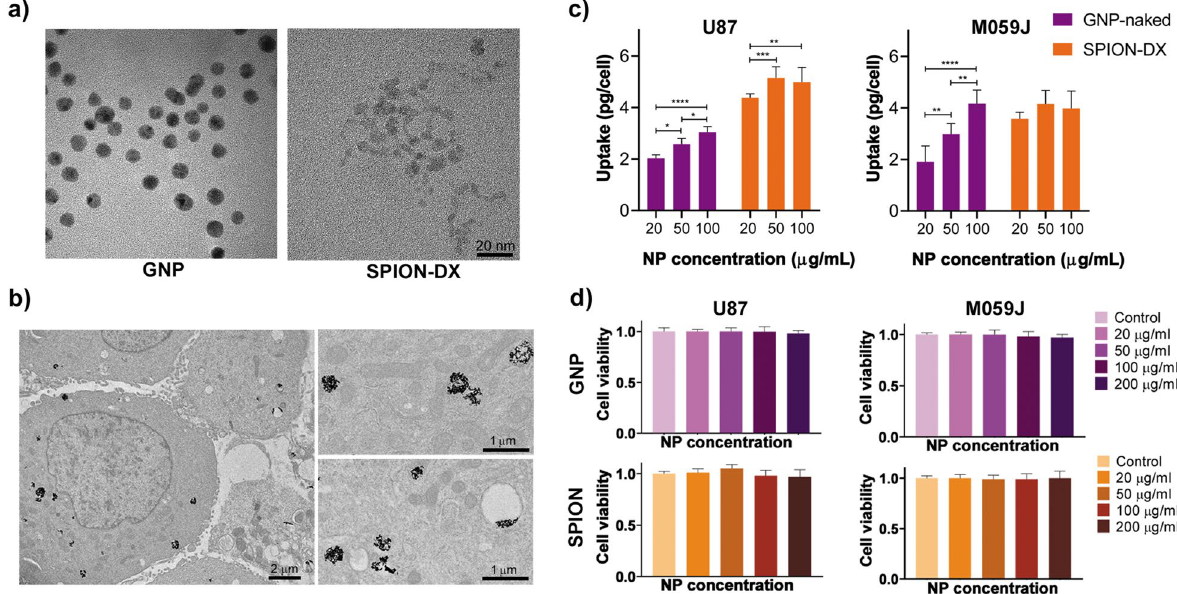
Figure 1. Nanoparticle characteristics and interaction with cells. ( a ) TEM images of GNPs (left) and SPION-DX (right). The scale bar applies to both images. ( b ) TEM micrographs of U87 cells exposed to 50 µ / mL GNPs showing NPs (black spots) localized within the cytoplasm. On the right, magnified TEM images from the same cell, showing the NP aggregates within vesicles. ( c ) Average metal (Au or Fe) uptake (in units of 10 per cell) determined using ICP-MS for U87 (left) and M059J (right) cells incubated for 24 h with different concentrations of GNPs and SPION-DX. p -values are presented as: * p < 0.05 ; ** p < 0.01 ; *** p < 0.001 ; **** p < 0.0001 . ( d ) MTT cell viability assay for U87 (left) and M059J (right) GBM cells after 24 h incubation with GNPs and SPION-DX at treatment concentrations of 20, 50, 100, and 200 µ